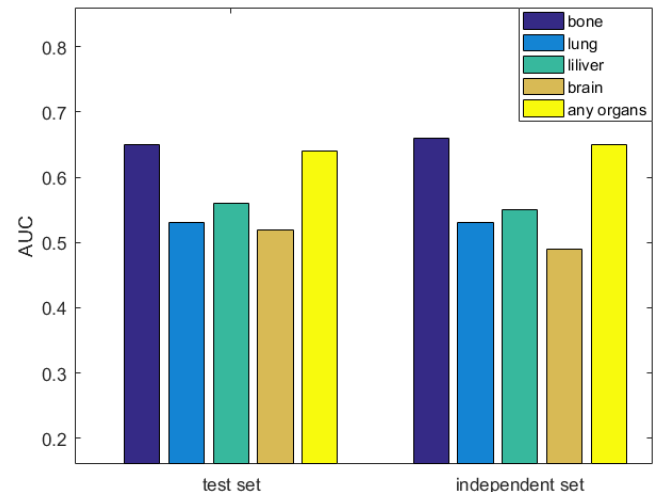
Figure 4. Comparing the performance of bone metastasis with other organ metastases. Table 3. Comparing results with estrogen receptor (ER) status.